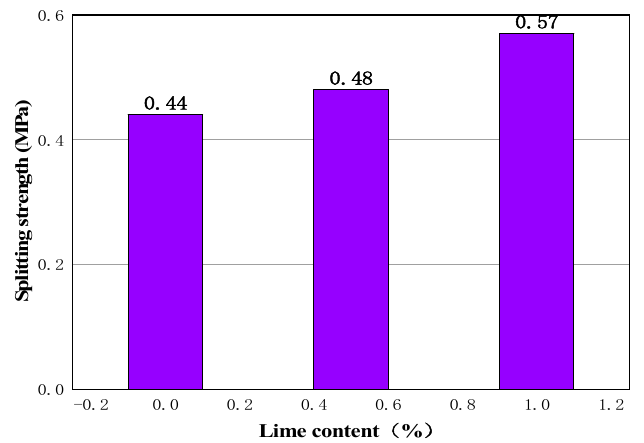
Figure 10. Influence of lime on the strength of a cold recycled specimen.